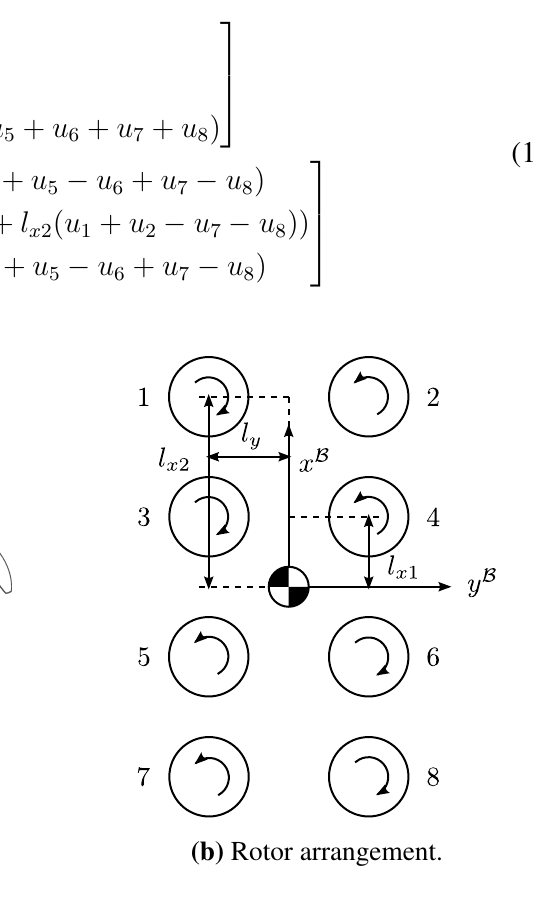
Figure 4. Octorotor configuration and the axes’